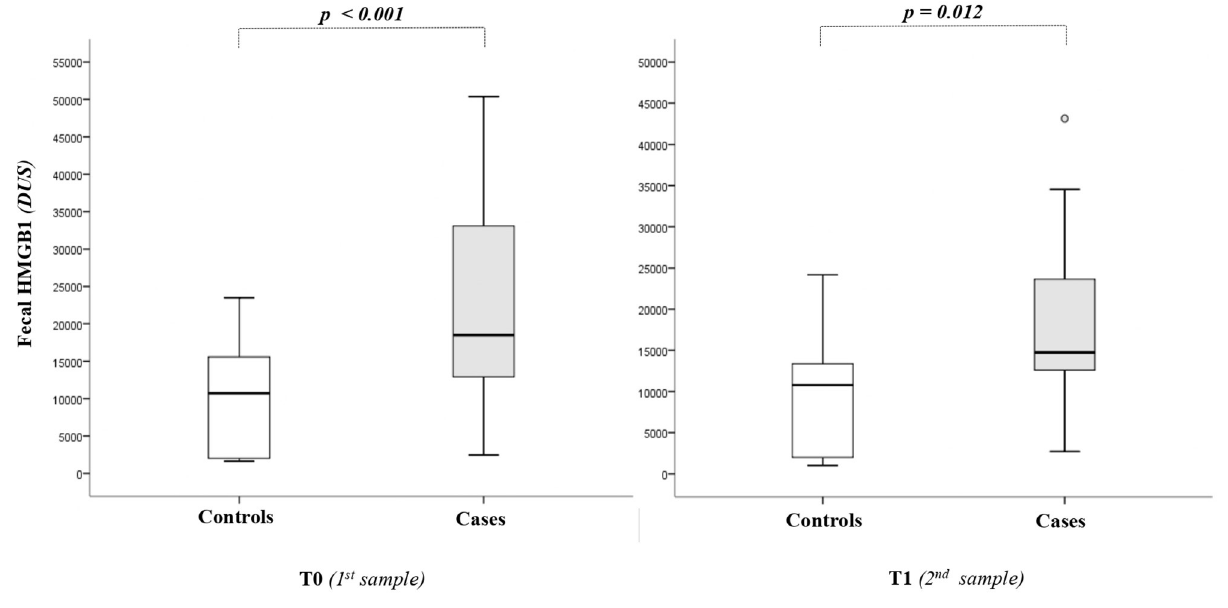
FIGURE 1 | High-mobility group box 1 (HMGB1) fecal levels. The spacing between different parts of the box indicates interquartile range. Horizontal bold black line indicates median. The whiskers above and below the box show the locations of the minimum and the maximum. HMGB1, high-mobility group box 1; DUS, densitometry units; NEC, necrotizing